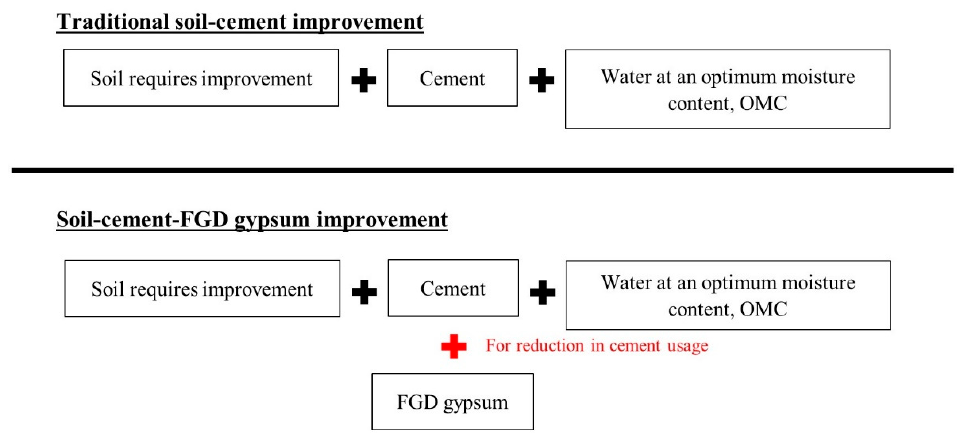
Figure 4. Traditional soil–cement process and the soil–cement–FGD gypsum process.